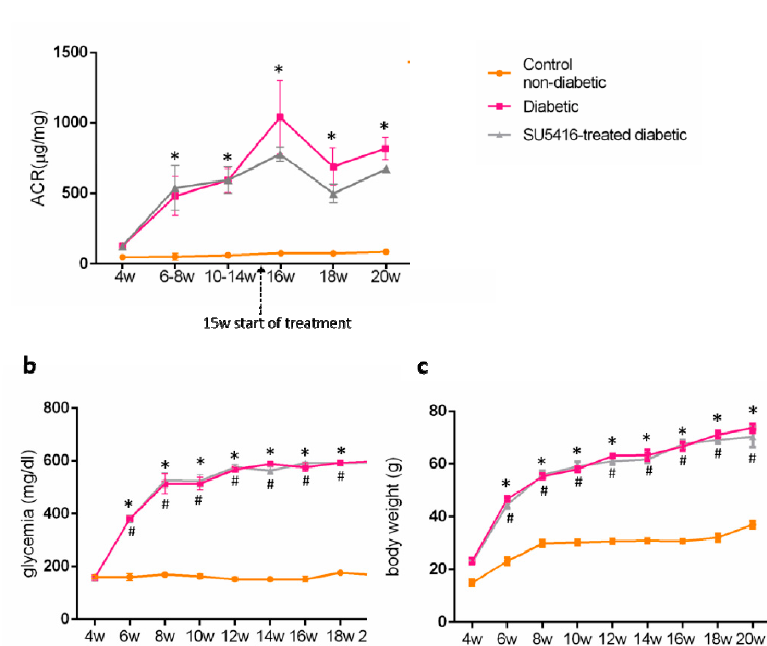
Figure 2. Effect of the VEGFR2 blockade on biochemical parameters in experimental diabetes. BTBR ob / ob mice (diabetic mice) were studied from the 4th to 20th weeks of age, and biochemical time-course determinations were done every 2 weeks. Occurring at 15 weeks, mice were randomly distributed into 2 groups: mice were treated with VEGFR2 kinase inhibitor SU5416 and vehicle-treated mice (diabetic group) and studied until week 20 (blood and kidney determinations were performed at the time of mice sacrifice). As a control group, non-diabetic mice (BTBR WT mice) were also studied. ( a ) Evolution of albuminuria determined as the albuminuria / creatinine ratio (ACR). Assessment over time of ( b ) glycemia and ( c ) body weight. Data as mean ± SEM of 6–8 mice per group. * p < 0.05 versus control non-diabetic, # p < 0.05 versus diabetic.